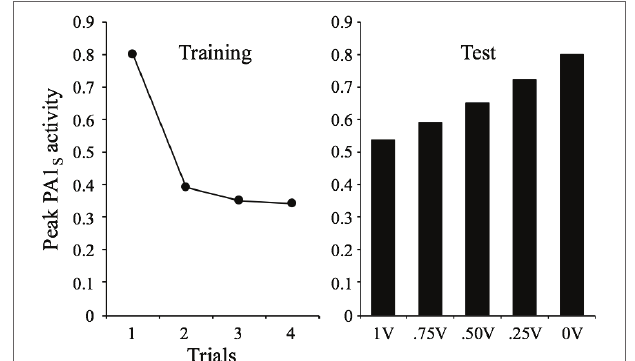
FIGURE 7 | Simulated peak PA1 S activity over 4 presentations of a 1-moment stimulus at a 32-moments inter-stimulus interval. The bar graph depicts the peak PA1 S activity in a single spontaneous recovery test-trial for stimuli that received a rate of 1, 0.75, 0.5, 0.25, and 0 of generalized V from the habituated